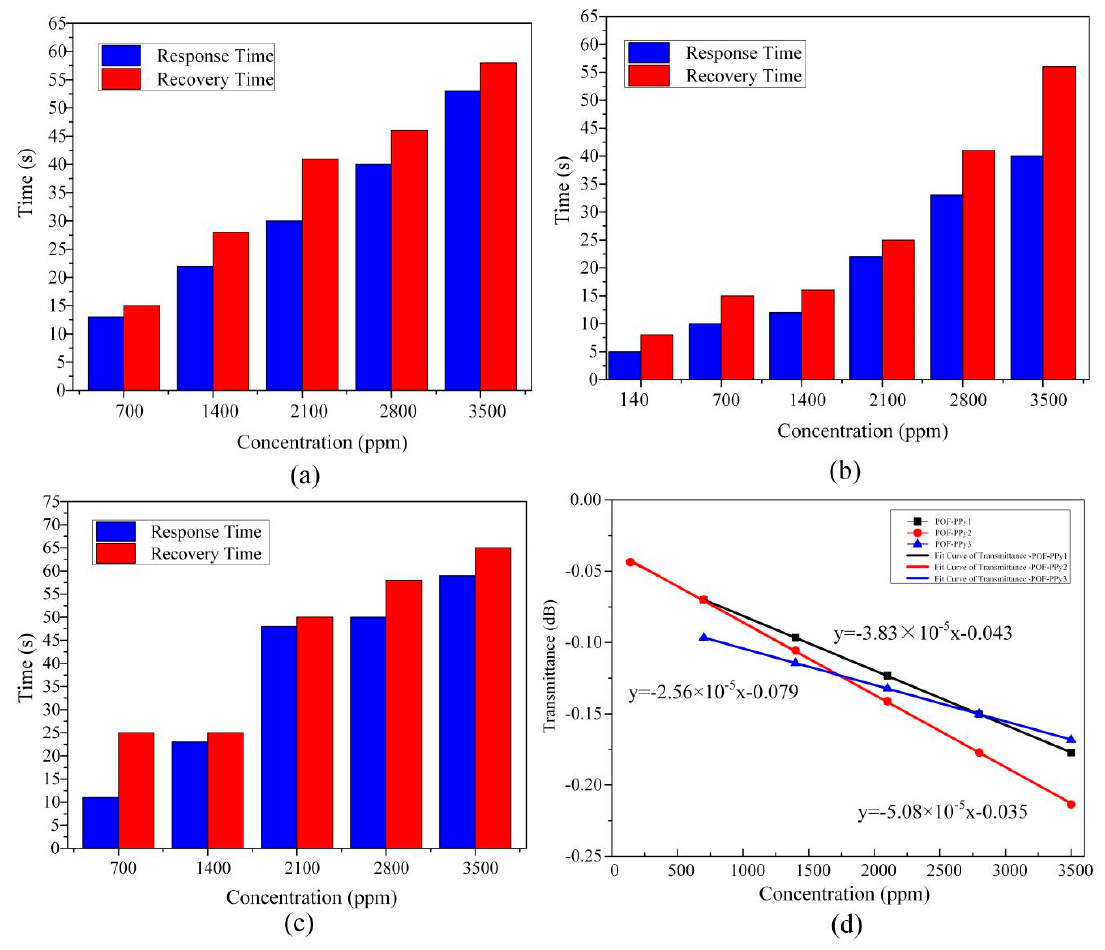
Figure 6. Response and recovery times of: ( a ) POF-PPy1, ( b ) POF-PPy2, ( c ) POF-PPy3, and ( d ) the sensitivity of the proposed sensor.